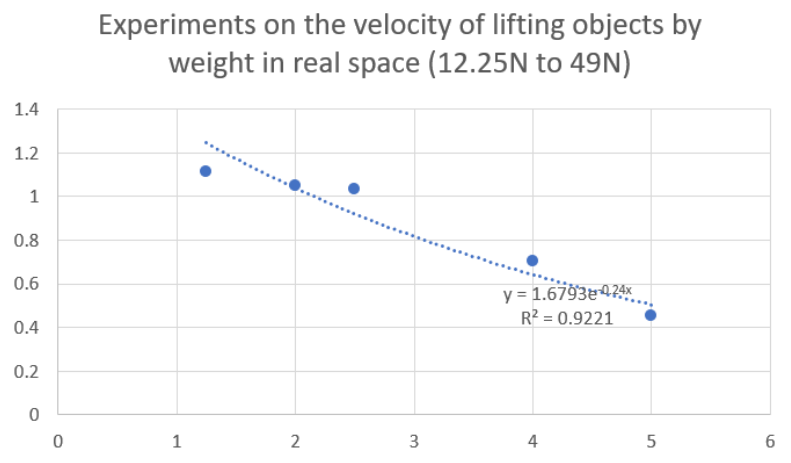
Figure 4. Experimental results for measuring the lifting speed of objects by weight in real space (from 12.25 N to 49 N).